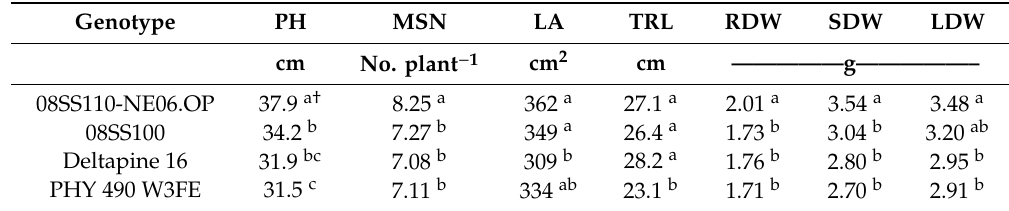
Table 8. Genotype e ff ect on morphological and physiological parameters of cotton at 60 days after planting. Genotype PH MSN LA TRL RDW SDW LDW cm No. plant − 1 cm 2 cm —————g—————– 08SS110-NE06.OP 37.9 a † 8.25 a 362